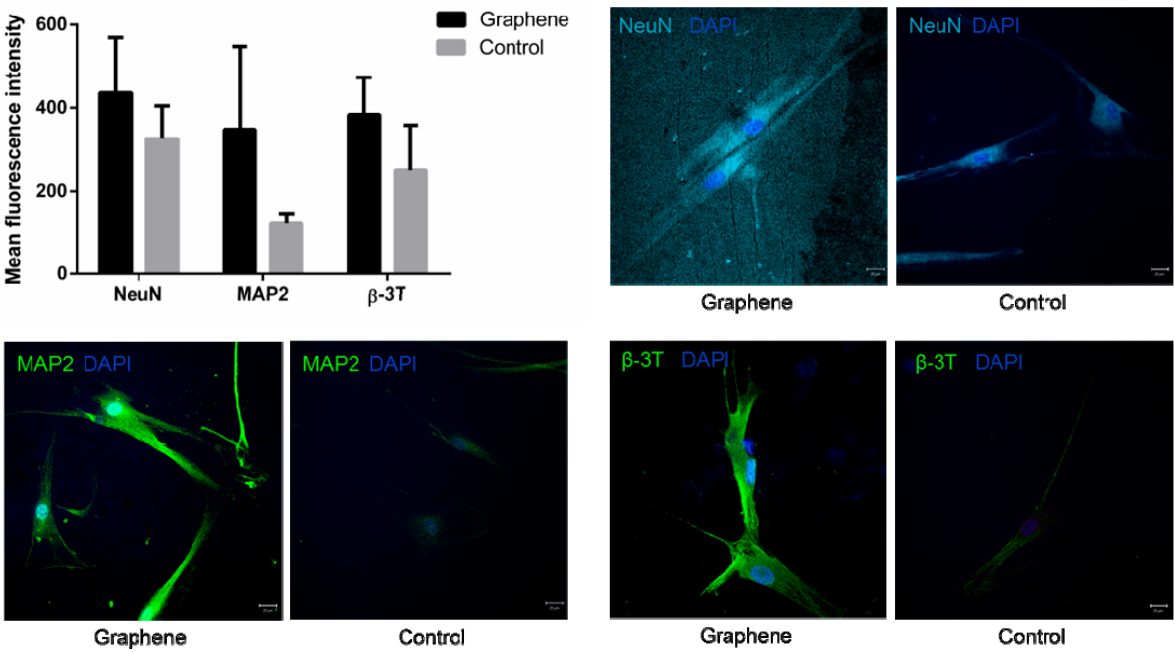
Figure 10. Mean fluorescence intensities and laser confocal micrographs of SCAP immunolabeled for neuronal markers NeuN, MAP2 and β 3-tubulin (nuclei are labeled with DAPI).